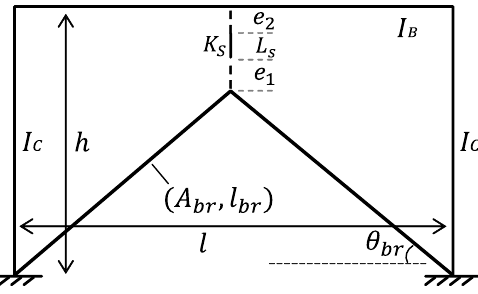
Figure 1. Theoretical model of structural mechanics.